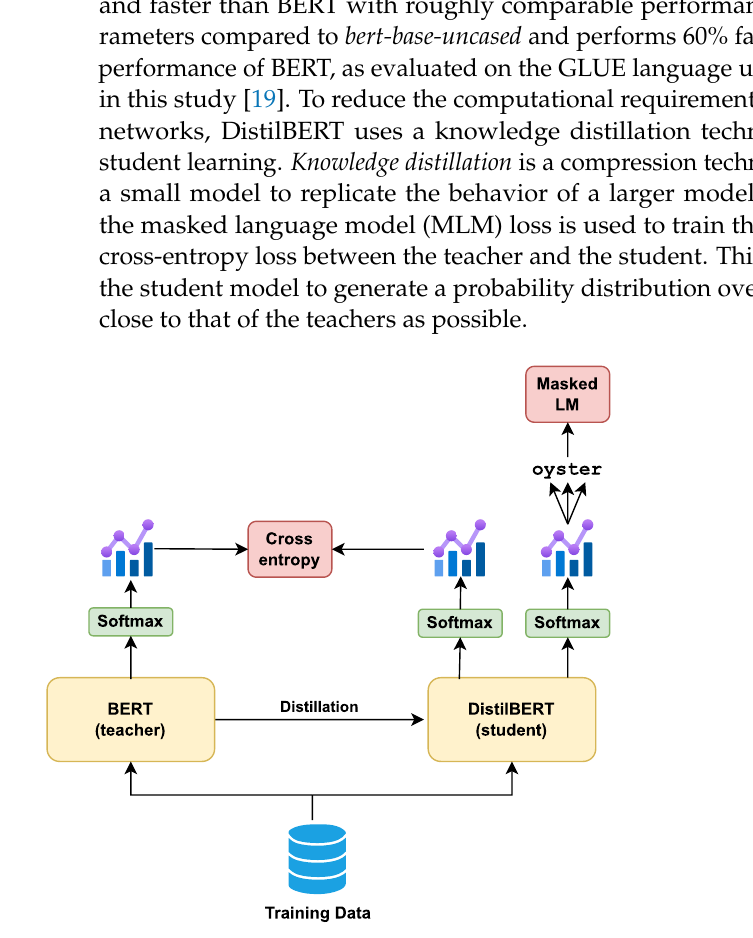
Figure 6. Knowledge distillation from BERT with the combination of cross entropy and the masked LM